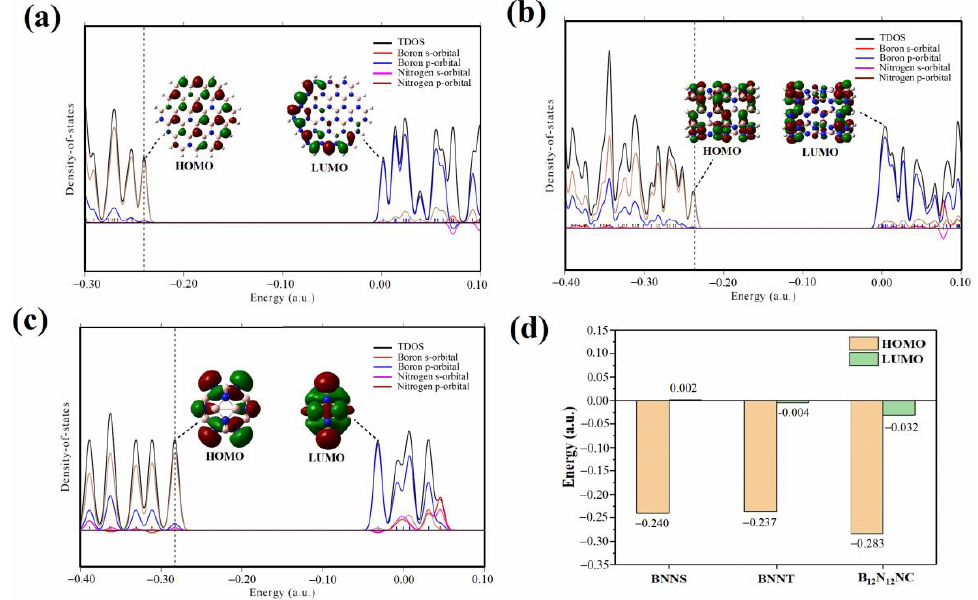
Figure 9. Density of state (DOS) plots of BNNS ( a ), BNNT ( b ), and BNNC ( c ) and their corresponding frontier molecular orbitals; ( d ) is the energy histogram of the HOMO orbitals and the LUMO orbitals of the three BN nanomaterials.